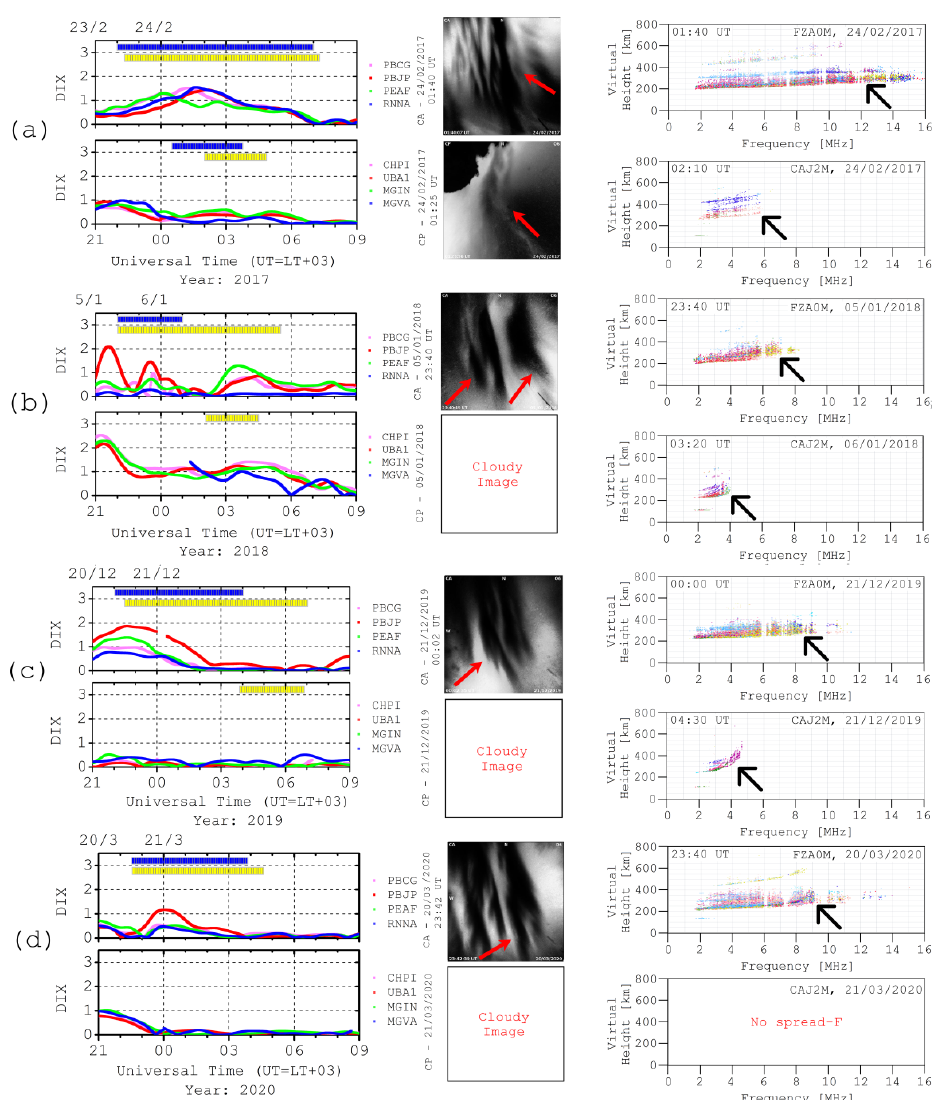
Figure 5. Time variations in the DIX for equatorial and low-latitude stations, along with OI 630nm airglow images taken at CA and CP, and ionograms showing the spread F occurrence at FZA0M and CAJ2M on 23–24 February 2017 (a) , 5–6 January 2018 (b) , 20–